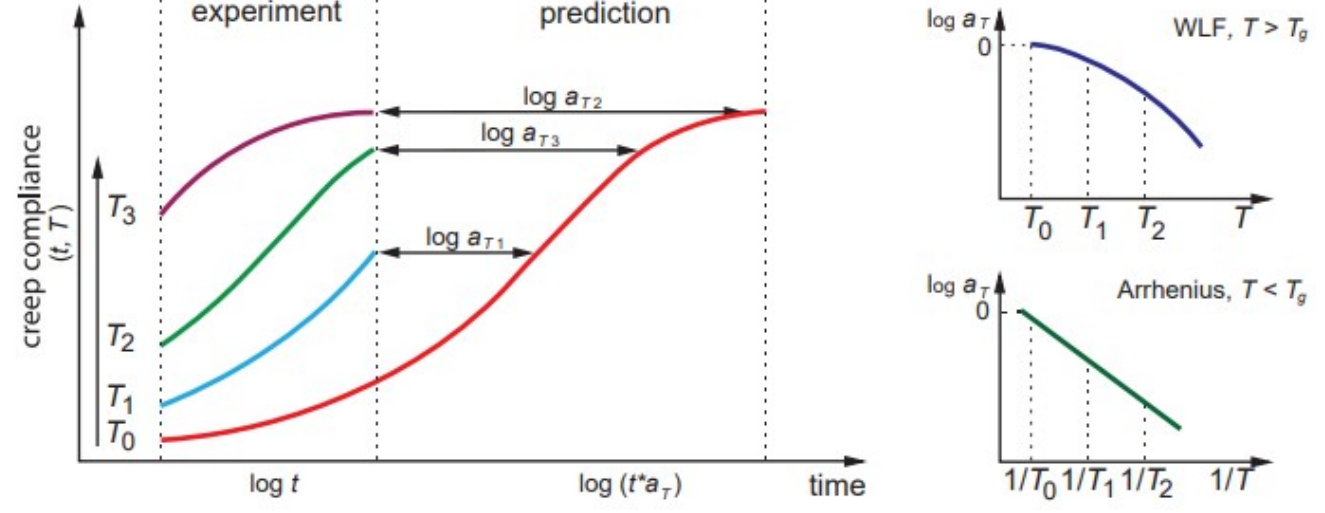
Figure 3. Superposition principles by the example of TTSP for creep compliance.